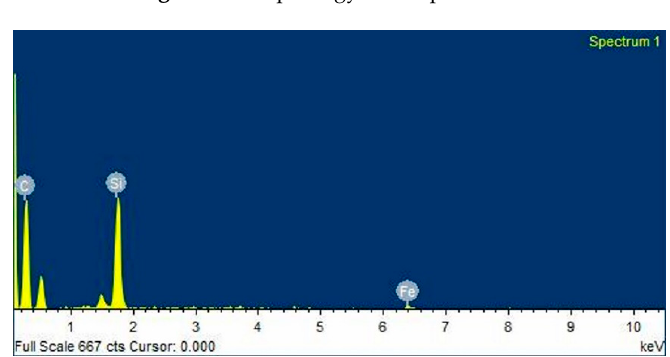
Figure 1. Morphology of SiC particulate.